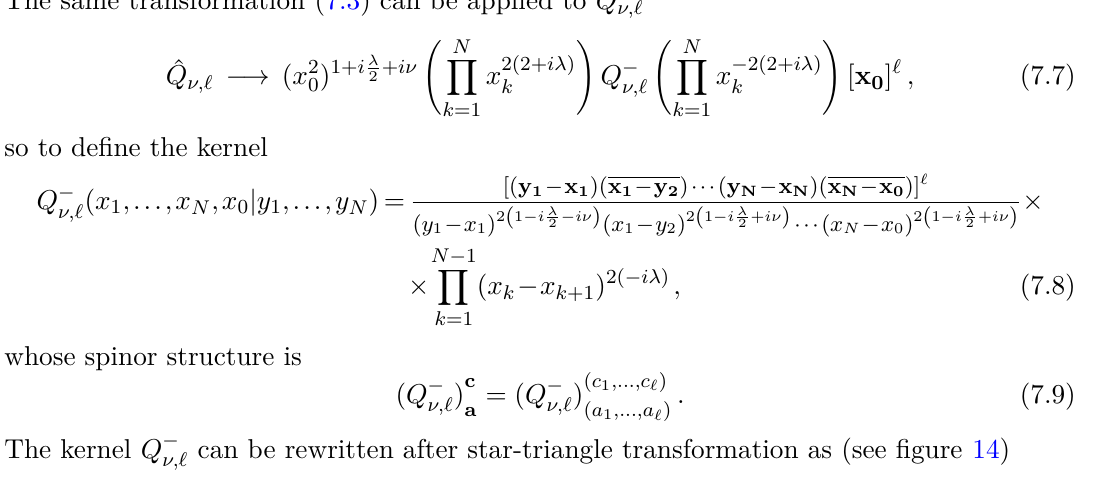
( x 1 , x 2 , x 3 , x 0 | y 1 , y 2 , y 3 ν,‘ ) as in formula